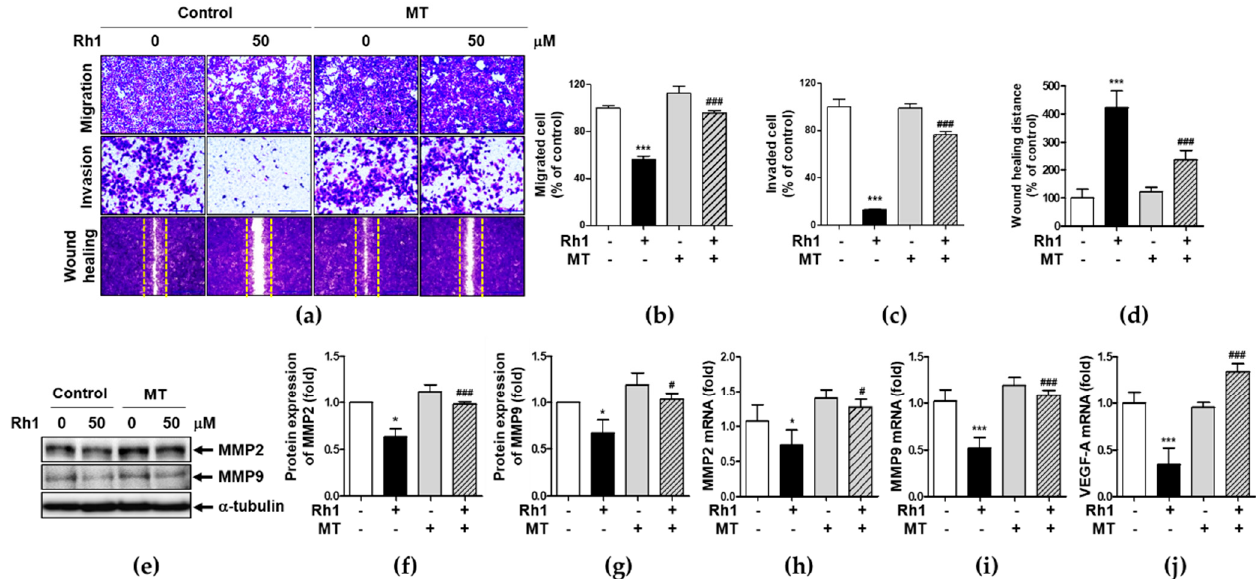
Figure 4. Mitochondrial ROS is associated with Rh1-inhibited cell migration and invasion. ( a ) MDA-MB-231 cells were pretreated with 5 µ M MT for 1 h followed by treatment with 50 µ M Rh1. After 36 h, cells were fixed, stained with crystal violet, and photographed using an Olympus microscope. Each Image indicates the migration (upper), invasion (middle), and wound healing activity (bottom) of MDA-MB-231 cells through polycarbonate membrane. The scale bar indicates 200 μ m. ( b – d ). The number of cells were counted and shown in the column graph of the corresponding pictures. ( e – j ) MDA- MB-231 cells were pretreated with 5 μ M MT for 1 h followed by treatment with 50 μ M of Rh1 for 12 h and whole protein lysates and mRNA samples were subjected to western blotting against MMP2 and MMP9 ( e – g ) or qRT-PCR against MMP2, MMP9, and VEGF-A ( h – j ). The data are presented as means ± SEM ( n = 3). * p < 0.05 or *** p < 0.001 compared with control. # p < 0.05 or ### p < 0.001 compared with MT alone.